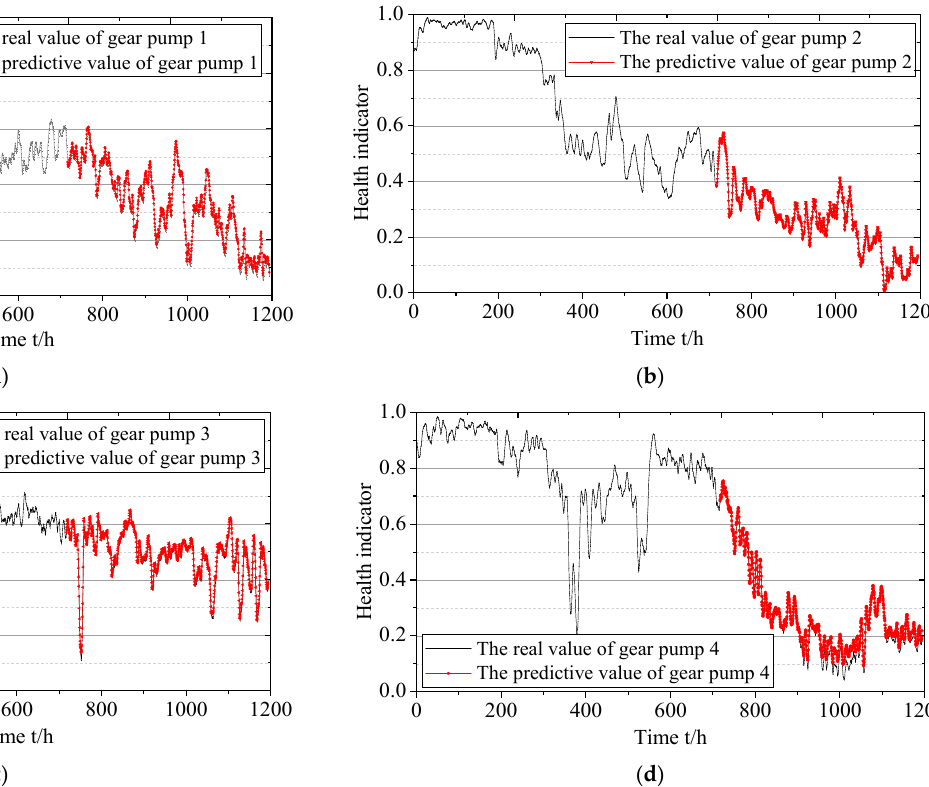
Figure 13. Health indicator prediction curve: ( a ) gear pump 1; ( b ) gear pump 2; ( c ) gear pump 3; and ( d ) gear pump 4.